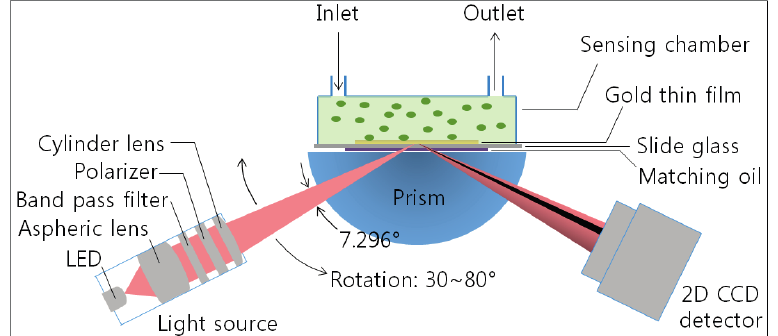
Figure 2. Schematic of our homemade SPR system based on angular interrogation of Kretchmann configuration. The p-polarized wedge-type incidence beam with a range of the directed to the SPR sensor chip through a cylindrical prism (BK7, n = 1.5125 at 770 nm). Then, the intensity of the reflected light beam is monitored using a two-dimensional complementary metal oxide semiconductor (2D-CMOS) image sensor (IDS Co.) with a 1.41 cm sensing area (1280 × 1024